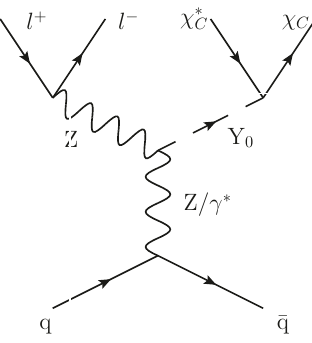
Figure 4 . Representative Feynman diagrams of the dark sector with a spin-0 mediator. For the S0 c model, there is no virtual photon